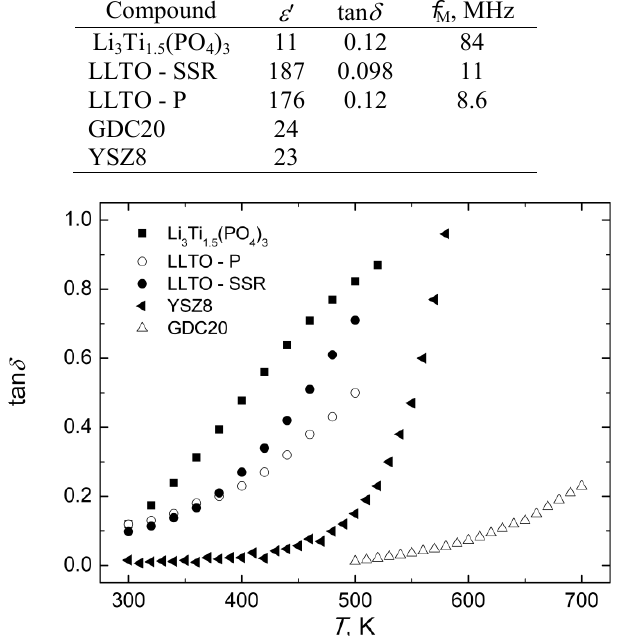
Figure 7: Temperature dependences of dielectric losses of LLTO, Li 3 Ti 1.5 (PO 4 ) 3 , GDC20, and YSZ8